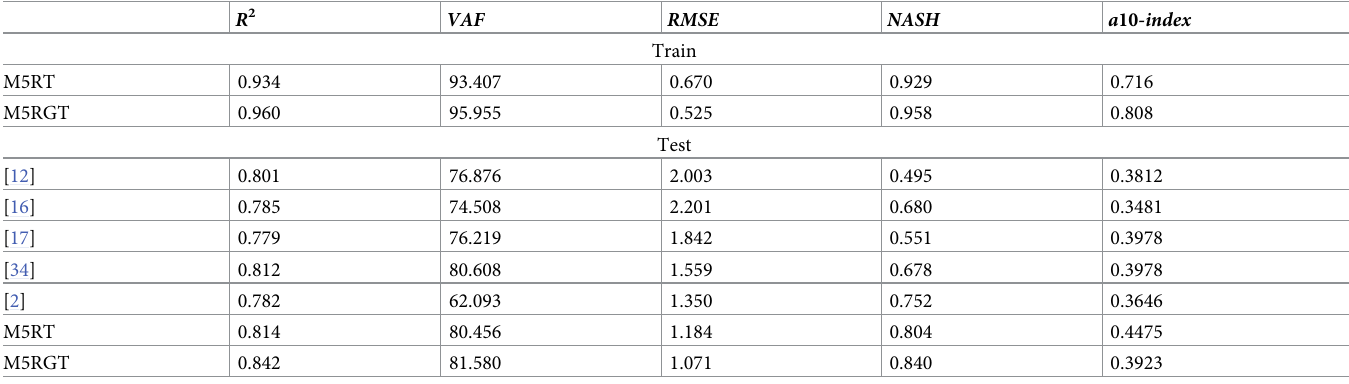
Table 5. Model performances with different statistical